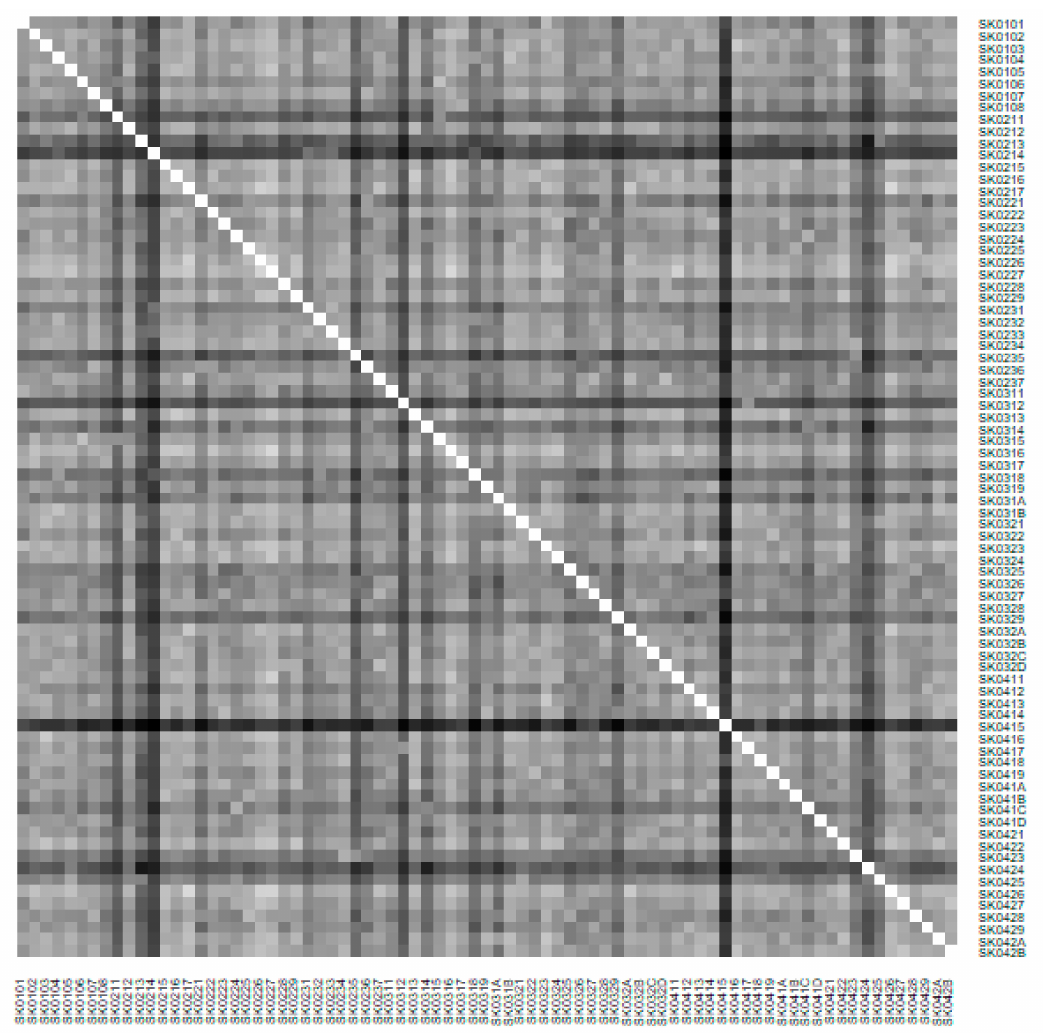
Figure 16. Preventable mortality heat map of the districts for the female sex in the year 2015. Source: own elaboration by the